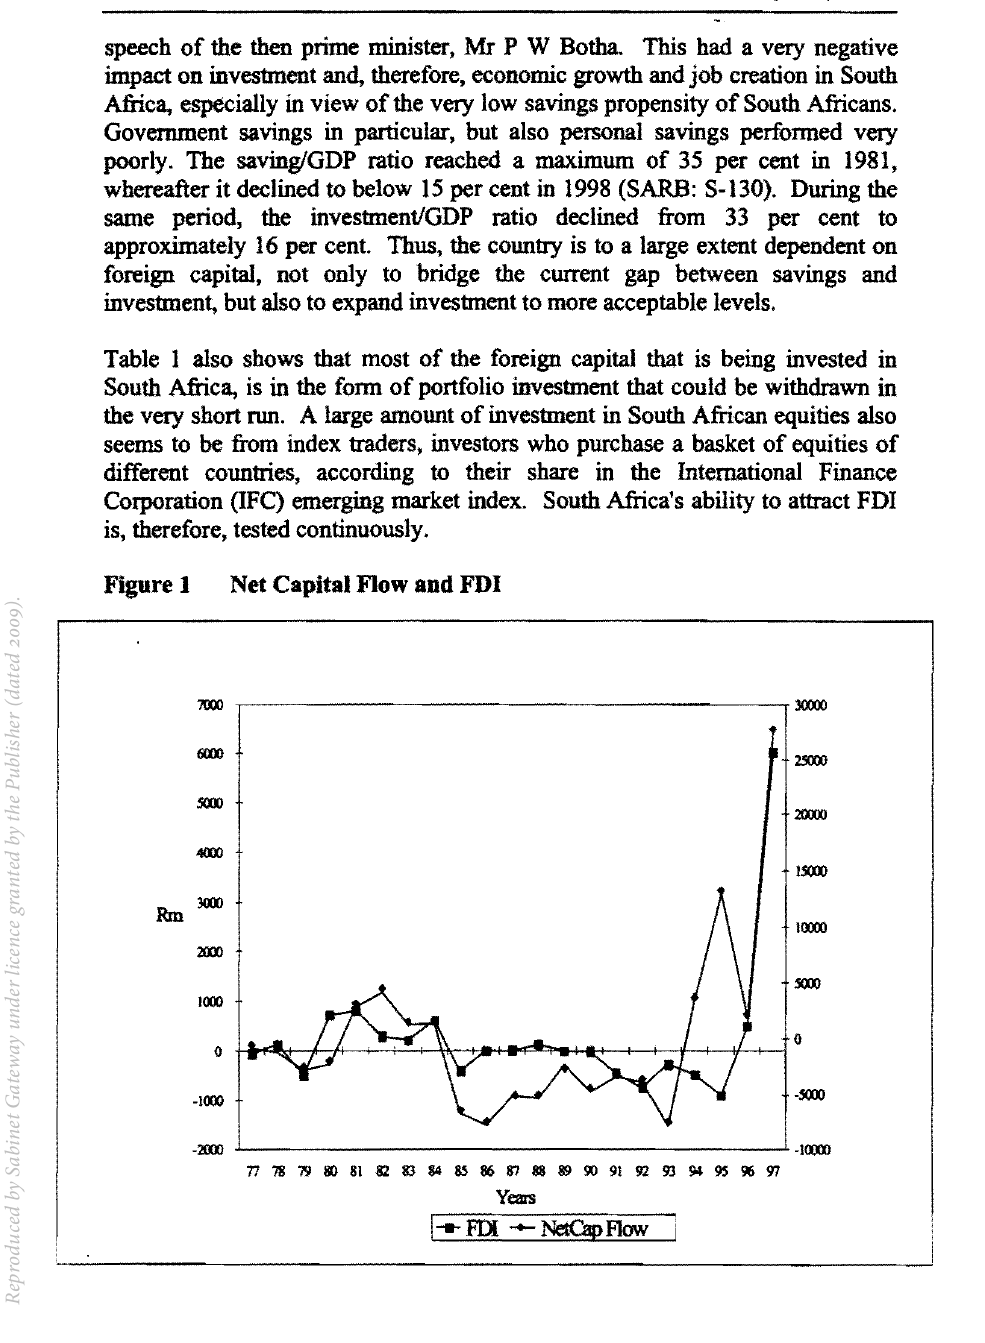
Net Capital Flow and